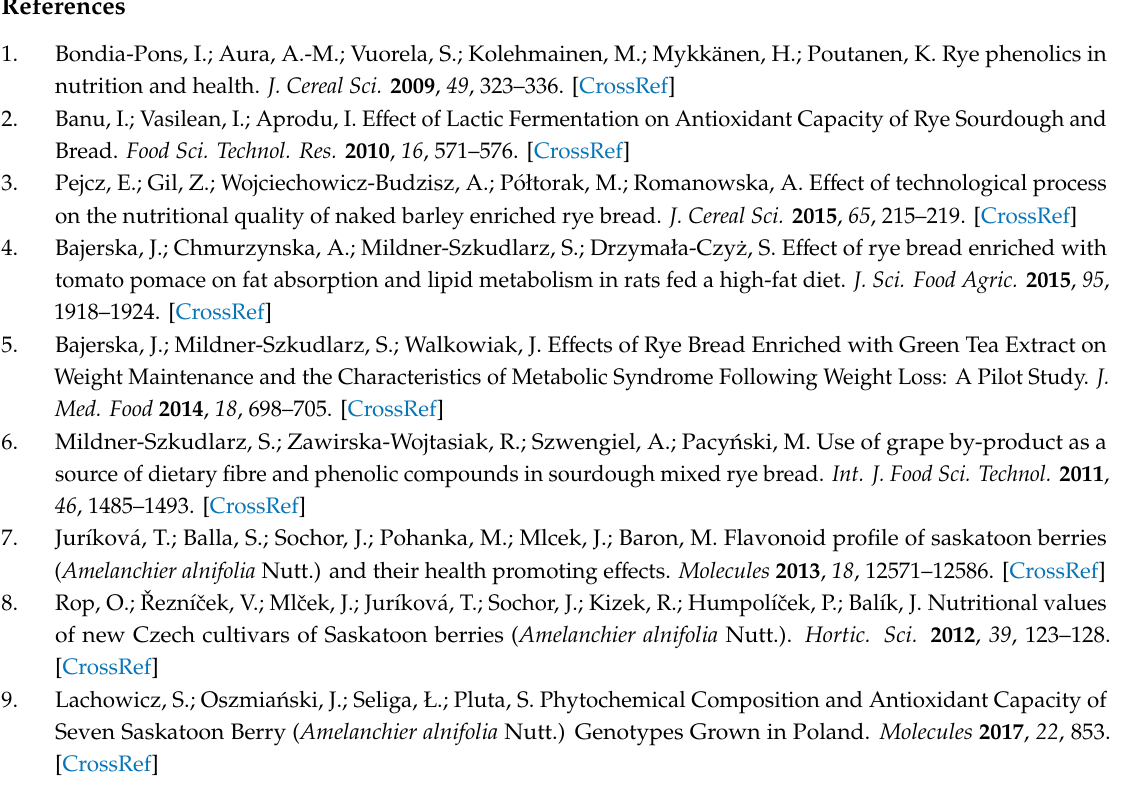
Table S1: The content of phenolic compounds in pure fruit powder, encapsulated fruit powders with maltodextrin, and encapsulated fruit powders with inulin [mg / 100 g